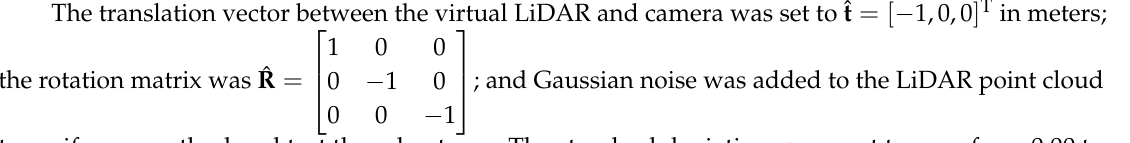
Figure 8. Simulation scene in Blensor. The yellow lines are LiDAR scan